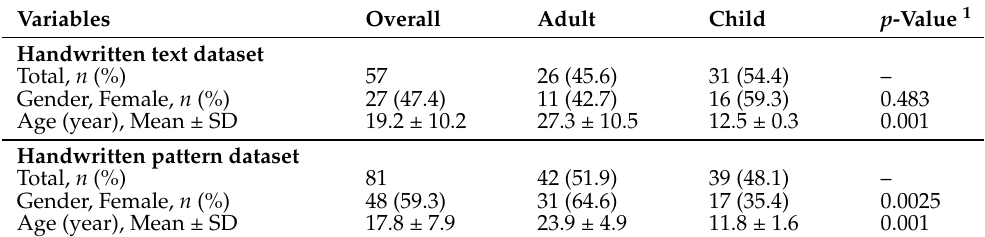
Table 4. Baseline characteristics of adult and child.